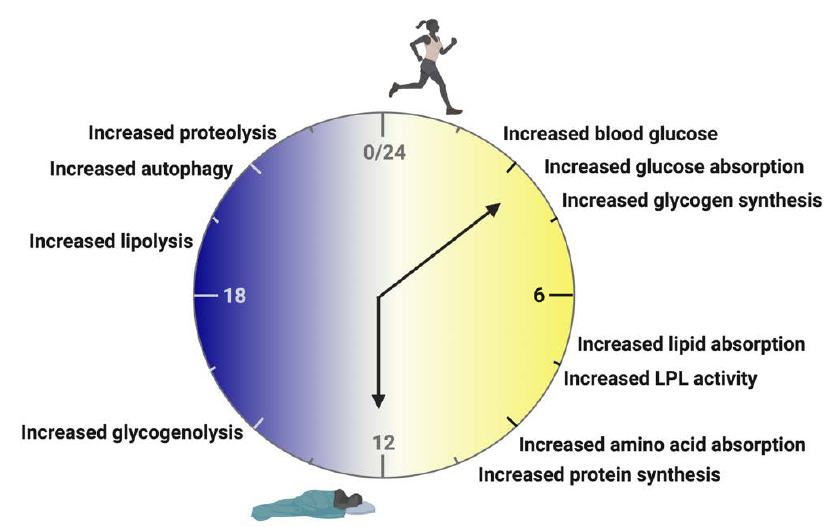
Figure 2. The Human Metabolic Clock. During the active phase, food consumption results in an increase in blood glucose that elicits an increase in glucose absorption and glycogen synthesis. Lipids are also absorbed more readily, and lipoprotein lipase (LPL) activity increases. Amino acid absorption and protein synthesis increase during active-phase food consumption. Carbohydrates are more easily metabolized during the early active phase, whereas lipids and proteins are metabolized preferentially during the late active phase. The inactive phase is characterized by an increase in catabolic processes. Glycogenolysis is upregulated and lipolysis is increased. During inactivity, glutamine synthase and autophagy pathways are upregulated. Created with BioRender.com (accessed on 28 June 2022).